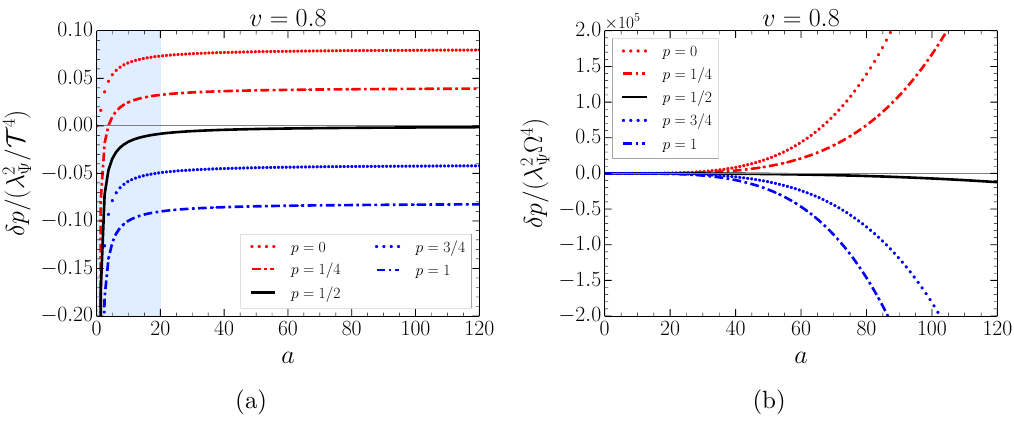
Figure 5. For (cid:12)xed v = 0 : 8, we plot the population change for the fermionic interaction, eq. (4.1), for a range of initially excited probabilities. The left (cid:12)gure (a) shows (cid:14)p (cid:9) in terms of (cid:21) 2 (b) presents this in terms of (cid:21) 2 (cid:10) 4 . (cid:9) initially excited probabilities and v = 0 : 8 as in (cid:12)gure 3a. This is a relevant way of